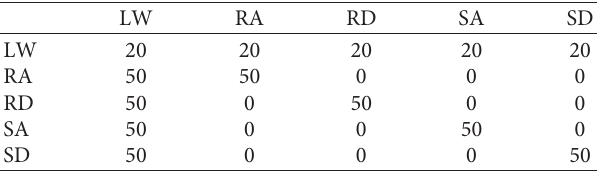
Figure 3: Architecture of the locomotion prediction scheme. Table 1: Transition probability between locomotion modes.